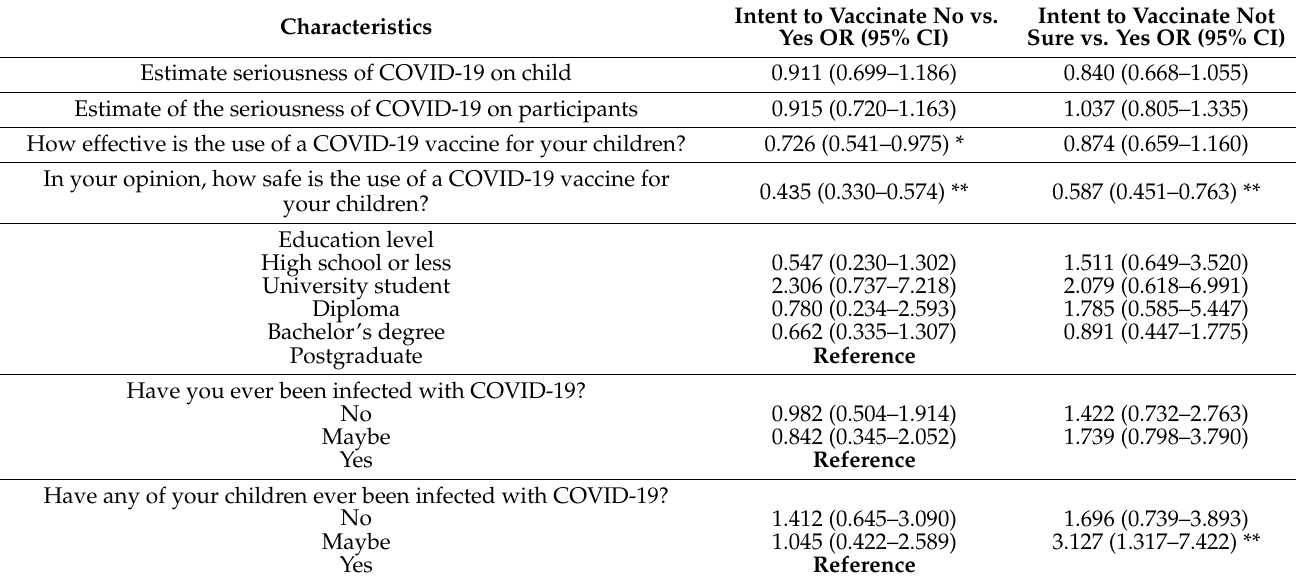
Table 3. Multivariate predictors of a participant’s responding “Not sure” or “No” to the question about their intention to vaccinate their